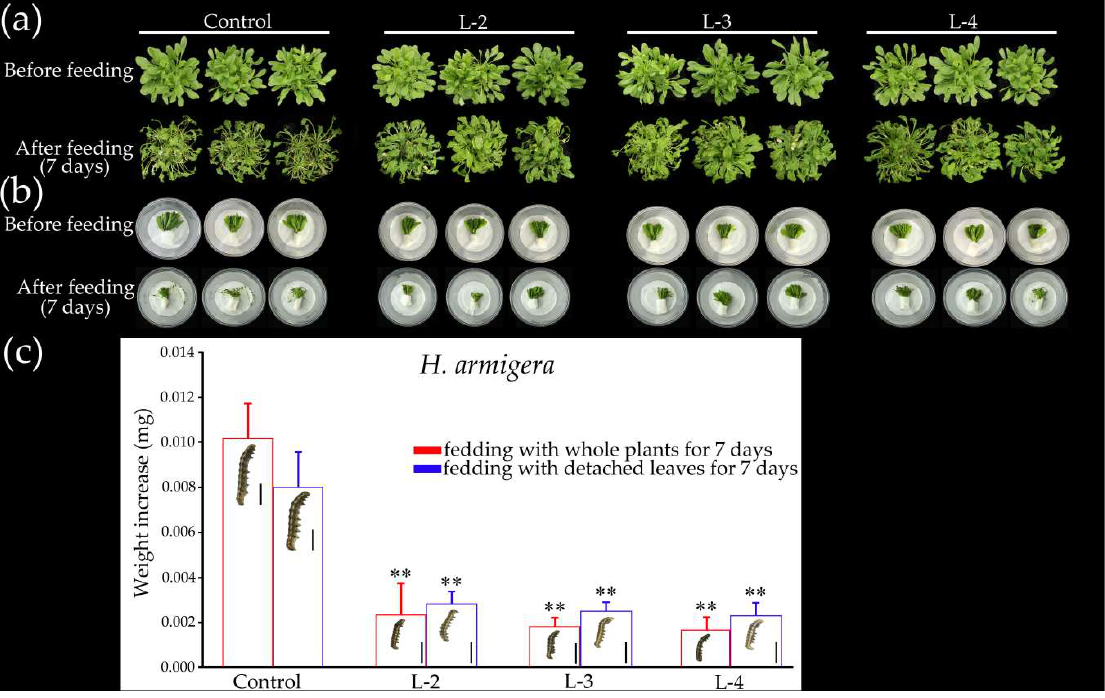
Figure 7. Overexpression of GsMYB15 enhances insect resistance in transgenic Arabidopsis plants. ( a ) Phenotypes of the control plants (Col-0) and GsMYB15 transgenic plant lines (L-2, L-3 and L-4) before and after H. armigera larval attack. ( b ) Phenotypes of detached leaves from the control plants (Col-0) and GsMYB15 transgenic plant lines before and after feeding with H. armigera larvae . ( c ) Weight increase of H. armigera larvae fed with whole plants or detached leaves from control plants (Col-0) and GsMYB15 transgenic plant lines for 7 days, respectively. Data are the means ± SDs ( n = 15). Shown in the column is an image of an H. armigera larva after feeding. Bar = 0.25 cm.